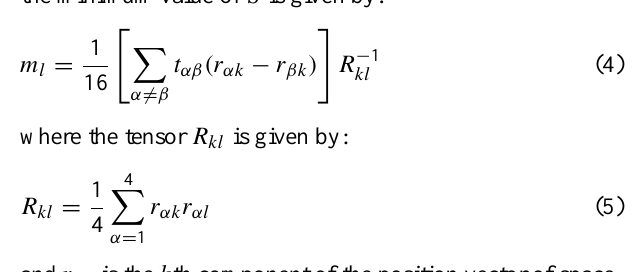
Fig. 5. The 90% “angular uncertainty” error angle for each of the 213 FTEs for which a velocity was obtained. The line indicates the threshold of 30 ◦ which was used to select well-defined events. At the beginning and end of the magnetopause crossing season the Cluster spacecraft tetrahedron quality was poor when the spacecraft crossed the magnetopause, and consequently some FTE velocities were determined with large errors. This was exacerbated in June by a spacecraft manoeuvre on 10 June 2003. All events after 10 June 2003 were discarded by Fear et al. (2005b), and are eliminated in the present study by applying a 30 ◦ threshold on the 90% angular